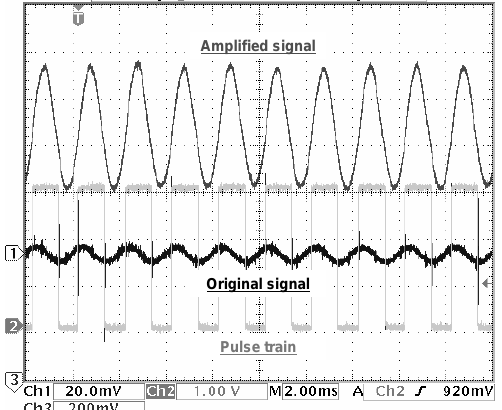
Figure 12. Measured sensor signals in signal-processor, where Ch1, Ch2 and Ch3 denote original signal, amplified signal and pulse train, respectively.